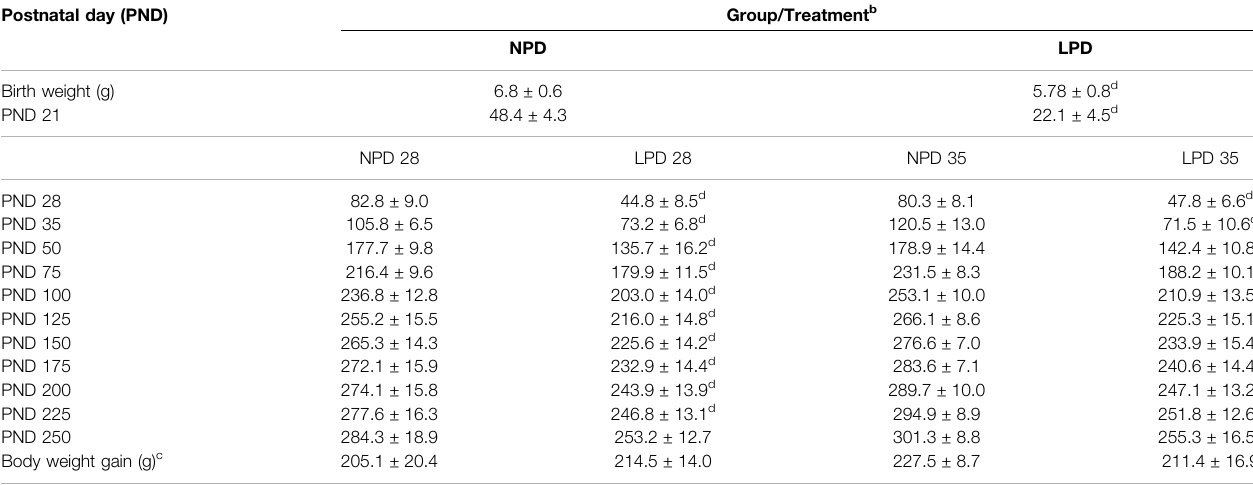
TABLE 1 | Effects of gestational and lactational low-protein diet and MNU administration on female offspring body weight evolution. a